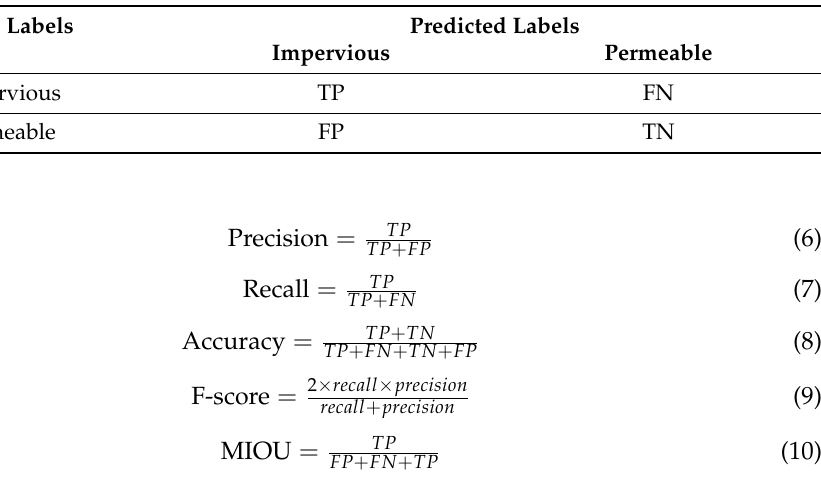
Table 2. Explanation of the confusion